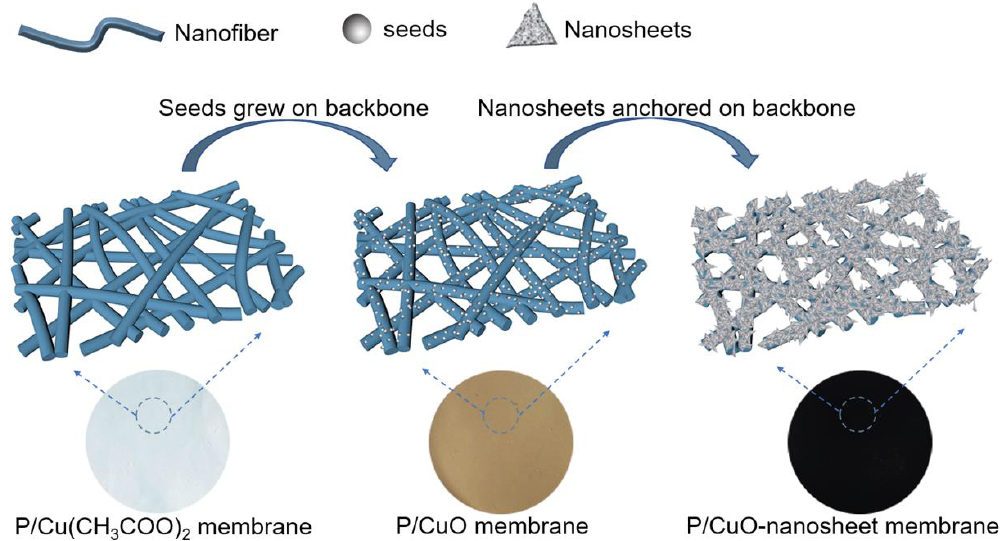
Figure 8. The schematic diagram of proposed formation mechanism for P/CuO nanosheet membrane.